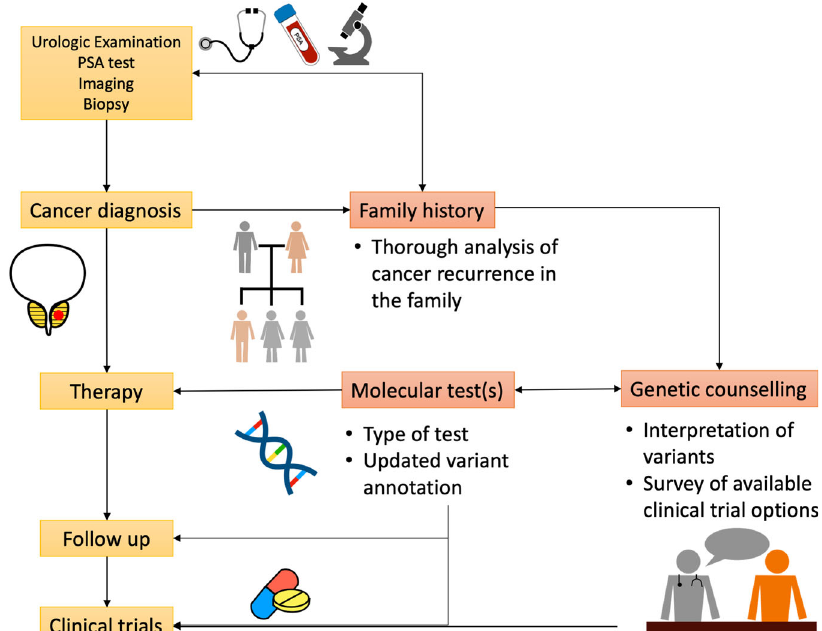
Fig. 1 Critical points in the clinical management of PCa patients in the frame of a precision medicine-based approach. The main critical points of attention are highlighted in